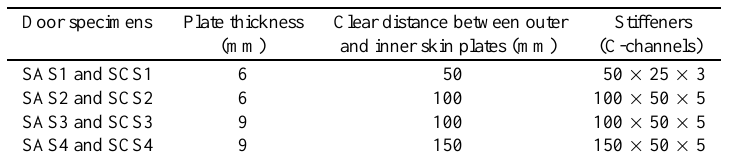
Table 3 Details of blast resistant doors used in field tests